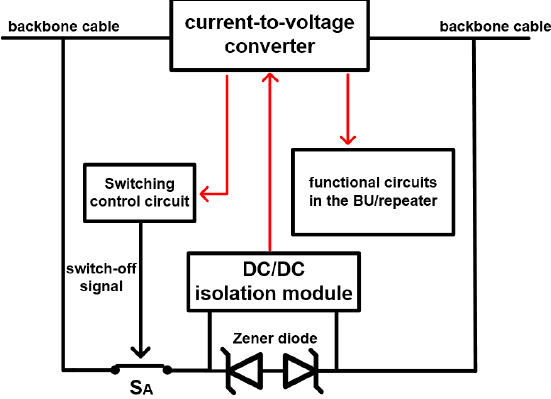
Figure 3. Startup operation of the current-to-voltage converter.